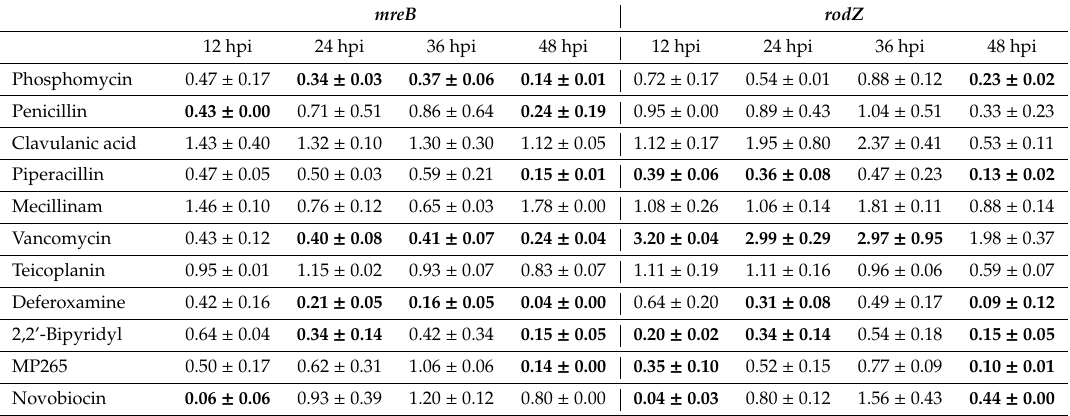
Table 2. Temporal fold change of mreB and rodZ genes in W. chondrophila in presence of diverse stress stimuli a . mreB